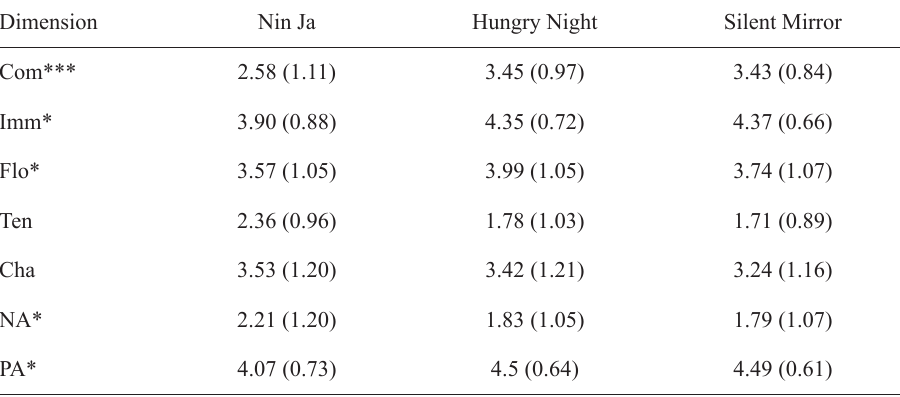
Table 7. Means of all dimensions of the core module by room theme Dimension Nin Ja Hungry Night Silent Mirror Com***